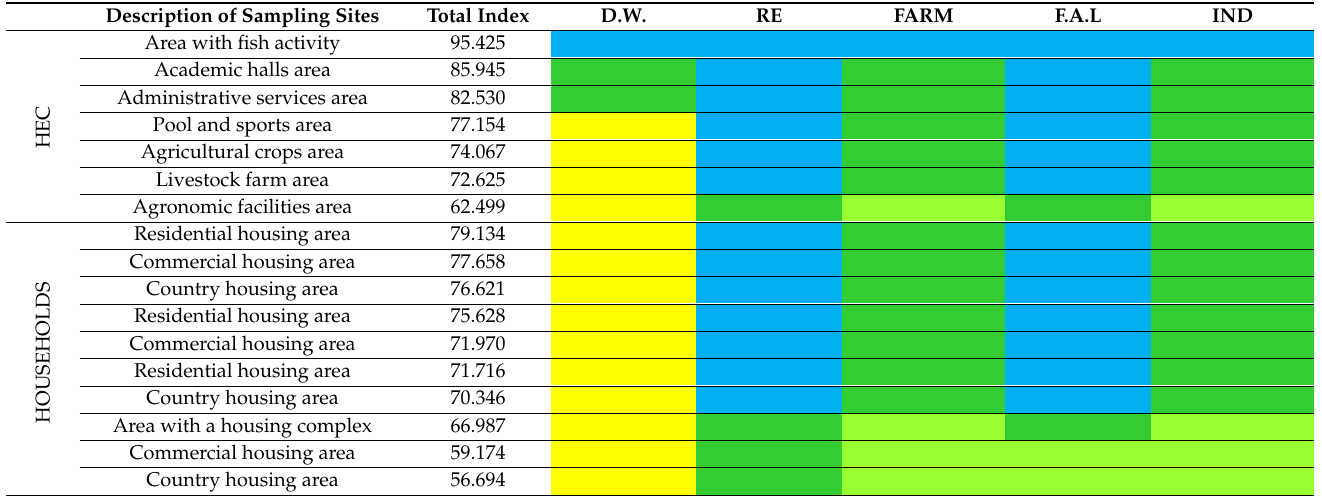
Table 7. Application of the Dinius Water Quality Index to groundwater